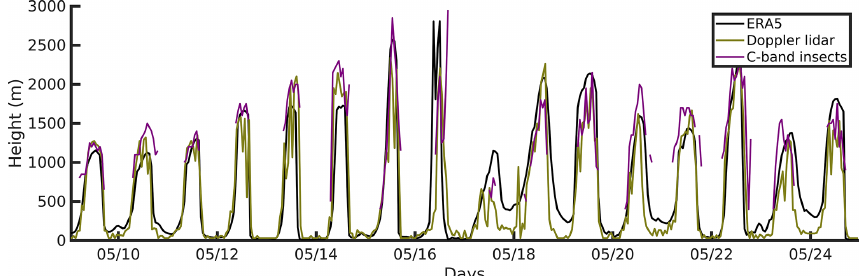
Figure 11. Time series of the CBLH during May 2018 derived using insects from the C-band radar compared to the HALO Doppler lidar retrievals and ERA5.